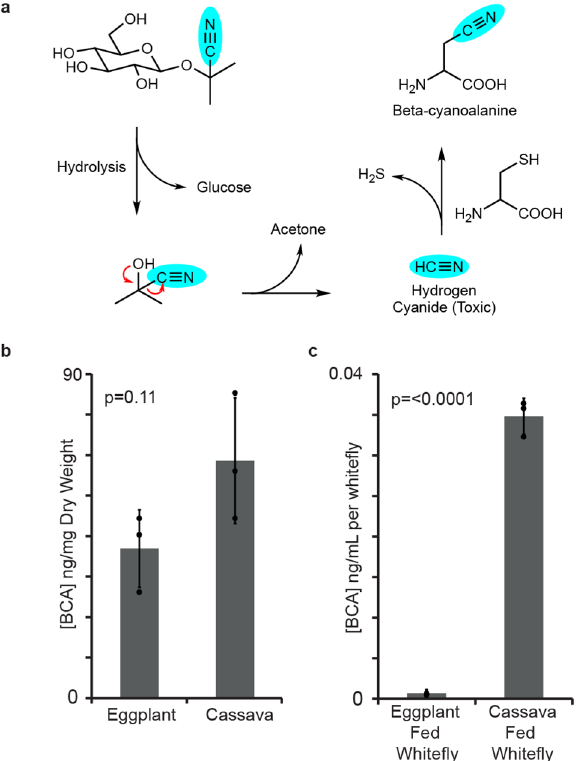
Figure 1. Beta-cyanoalanine levels support the activation of cassava cyanogenic glycosides during B. tabaci feeding. ( a ) Scheme showing the hydrolysis of the cyanogenic glycoside linamarin and the detoxification of the hydrogen cyanide released via beta-cyanoalanine formation. ( b ) Endogenous beta-cyanoalanine (BCA) concentrations in both eggplant and cassava leaves were not different (amounts depicted have been normalized per plant dry weight, P-value from unpaired t-test with N = 3). ( c ) Extracts from groups of 200 B. tabaci SSA1-SG3 adults feeding on cassava contained elevated levels of BCA in comparison to extracts from eggplant- fed insects (amounts depicted have been normalized per insect, P-value from unpaired t-test with N =